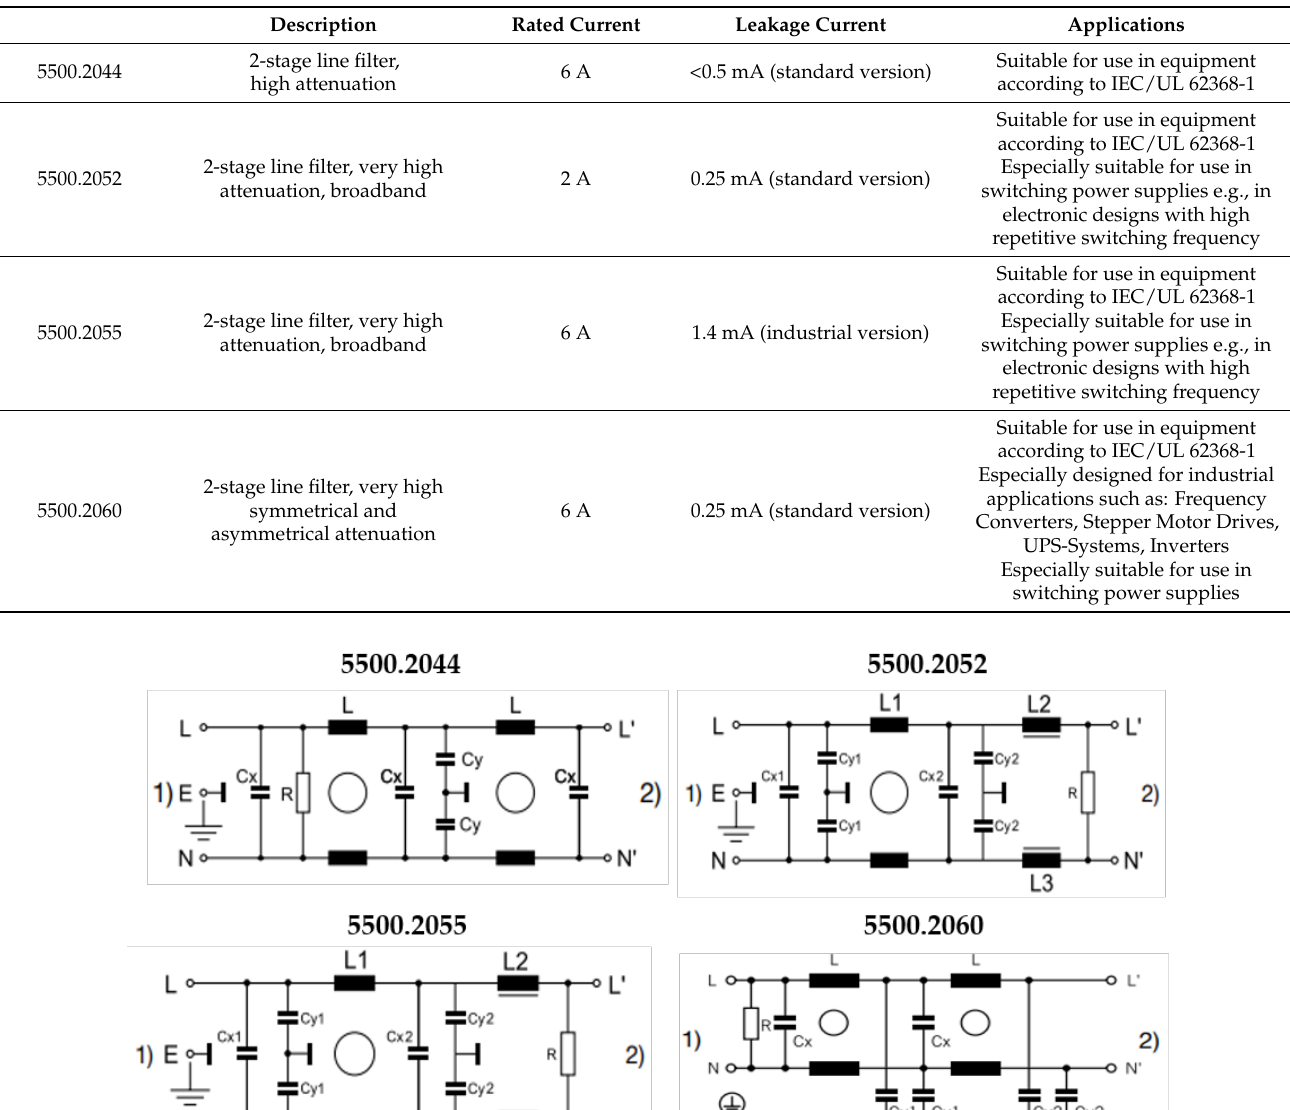
Table 1. Characteristics of the four Electromagnetic Compatibility (EMC) filters [16].